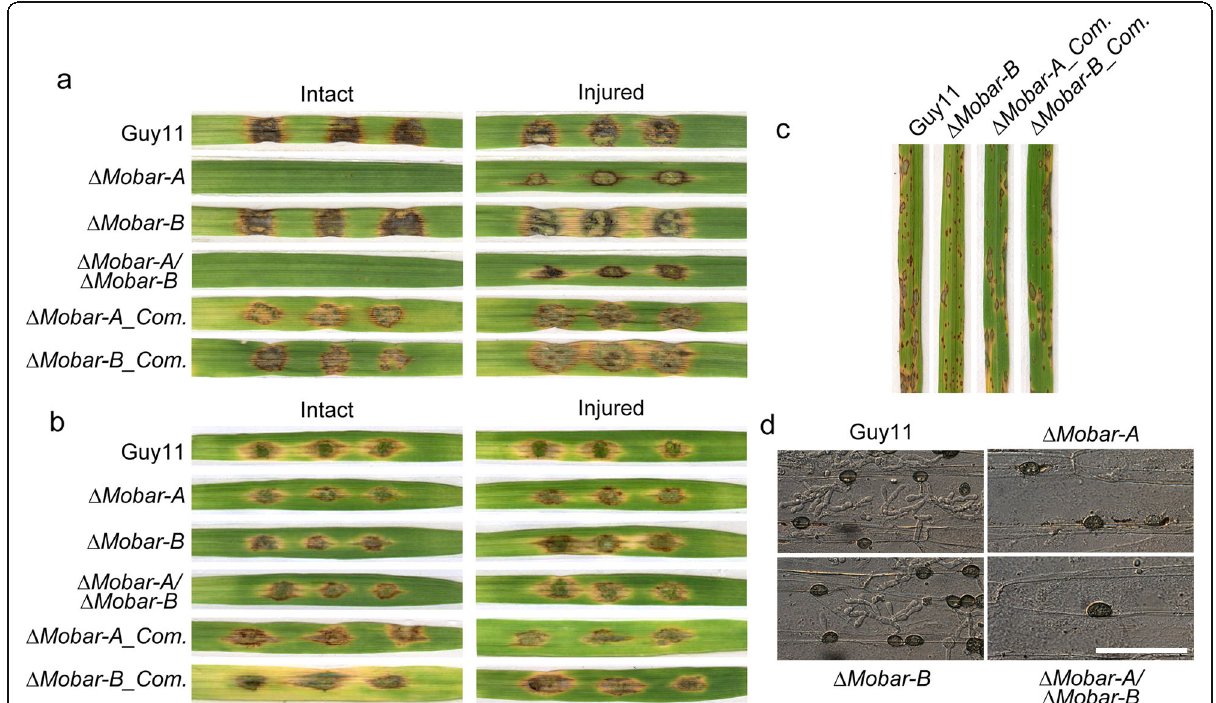
Fig. 5 MoBar-A contributes exclusively to hyphae-mediated initiation of blast infection on intact host tissues. a Development of blast infection on intact and injured barley leaves inoculated independently with hyphae harvested from the wild-type, Δ Mobar-A , Δ Mobar-B , Δ Mobar-A / Δ Mobar-B , Δ Mobar-A _Com. and Δ Mobar-B _Com. strains. b Development of blast infections on intact and injured barley leaves inoculated independently with drops of spore suspension (5 – 10 spores/20 μ L containing 0.02%v/v Tween20) obtained from the wild-type, Δ Mobar-A , Δ Mobar-B , Δ Mobar-A / Δ Mobar-B , Δ Mobar-A _Com. and Δ Mobar-B _Com. strains. c Disease lesions formed on susceptible rice cultivar ‘ CO39 ’ after independent spray inoculation with spore suspension (1 × 10 3 spores/mL containing 0.02% Tween20) obtained from wild-type, Δ Mobar-B , Δ Mobar-A _Com. and Δ Mobar-B _Com. strains. d Penetration and colonization capabilities of the Δ Mobar-A , Δ Mobar-B , Δ Mobar-A / Δ Mobar-B and the wild-type strains cultured on rice bran medium for 10 days. Bar, 10 μ